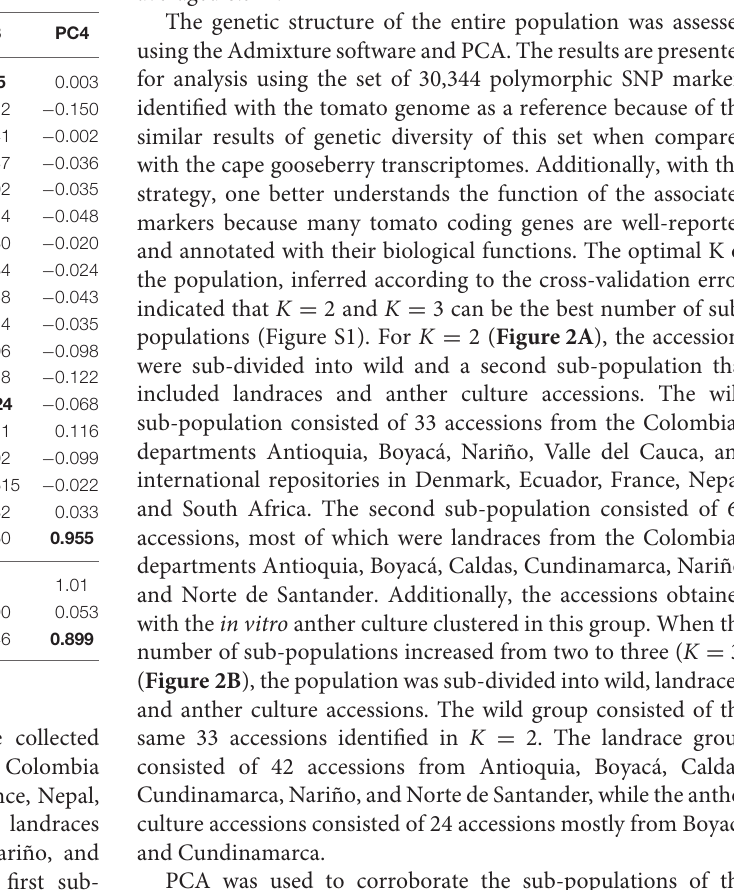
TABLE 3 | Eigenvectors and eigenvalues for the first four principal components